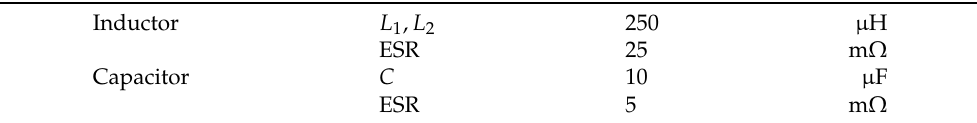
Table 3. HSU converter